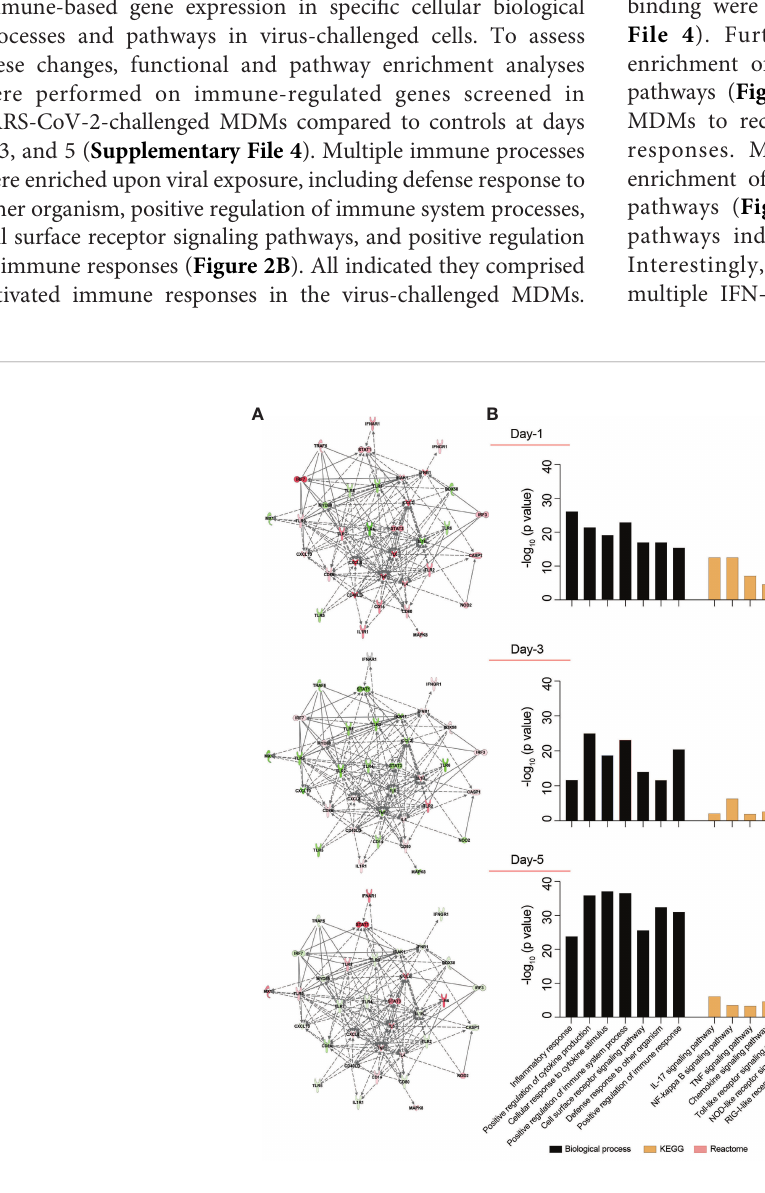
FIGURE 2 | Transcriptomic pro fi le of SARS-CoV-2-challenged MDMs. Expression of 84 genes speci fi c for human innate and adaptive immune responses were screened in SARS-CoV-2-challenged MDMs compared to mock-challenged MDMs at different times post-challenge, using RT 2 Pro fi ler Human Innate and Adaptive Immune Response 96-well Array. Fold changes in the gene expression were determined via Qiagen ’ s RT 2 Pro fi ler analysis software (n=4 donors). (A) IPA was performed with upregulated or downregulated genes to identify putative network interactions involved in SARS-CoV2-MDM interactions. Upregulated genes are shaded red with darker shade indicating higher upregulation, while green shades denote downregulation in gene expression. Solid grey lines indicate direct interactions, while dotted grey lines correspond to indirect interactions. (B) Functional and pathway enrichment analysis of transcriptomic dataset was performed using GO-term, KEGG, and Reactome analyses at different time points post-infection. Different immune and in fl ammation-related biological processes and pathways affected in SARS-CoV-2-challenged MDMs were plotted as a bar chart compared to mock-challenged